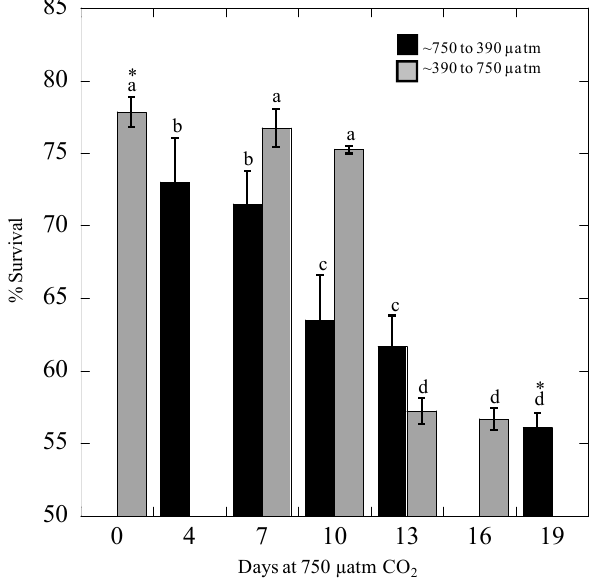
Figure 3. Mean RNA:DNA (± 1 SD) and mean, shell-based, specific growth rates (± 1 959 Fig. 3. Mean RNA:DNA (±1SD) and mean, shell-based, specific SD) for Mercenaria mercenaria (day 24) and Argopecten irradians (day 20) larvae n = 960 growth rates (±1SD) for Mercenaria mercenaria (day 24) and Ar- 15 larvae per treatment. Larvae were grown under CO 2 concentrations of approximately 961 gopecten irradians (day 20) larvae, n = 15 larvae per treatment. 250, 390, and 750 µatm CO 2 (Table 3). Letters indicate significant differences revealed 962 Larvae were grown under CO 2 concentrations of approximately from Tukey post-hoc multiple comparisons, p ≤ 0.05 for all. 963 964 250, 390, and 750µatm CO 2 (Table 3). Letters indicate significant differences revealed from Tukey post hoc multiple comparisons, p ≤ 0 . 05 for all.